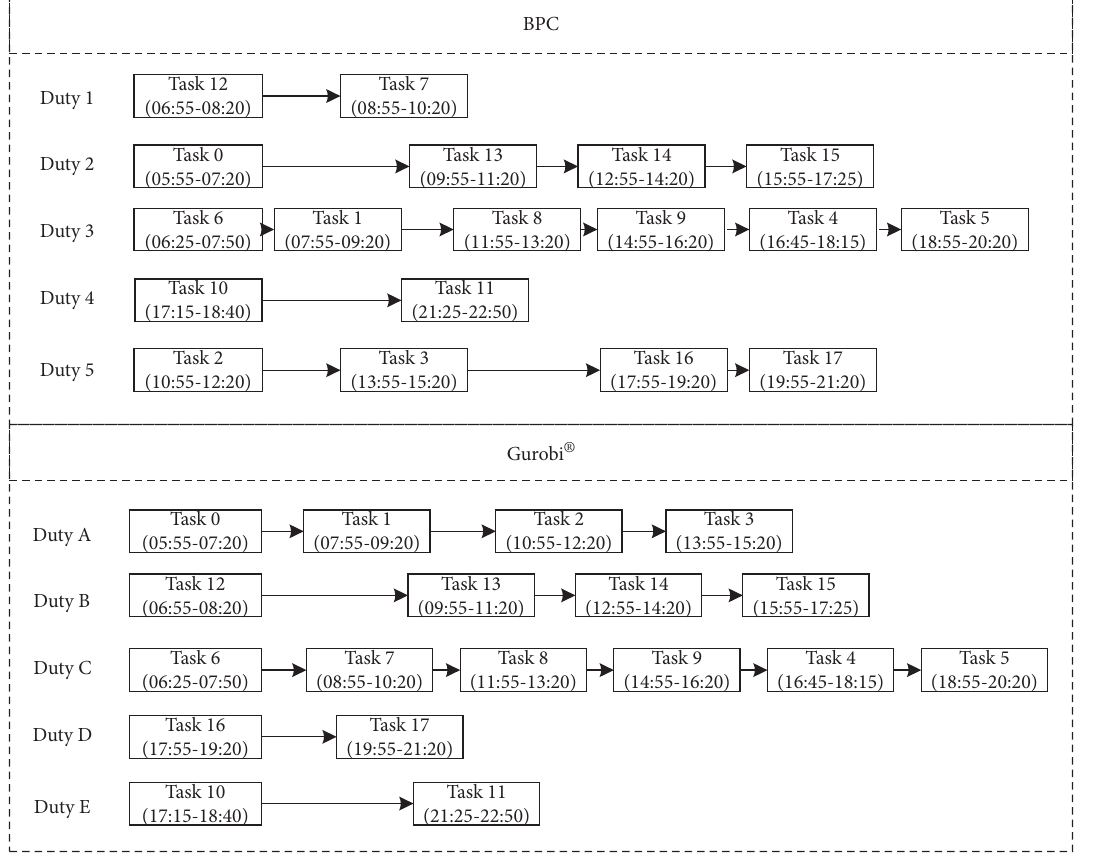
Figure 8: The scheduling of instance A from the Gurobi ® package and the BPC algorithm.